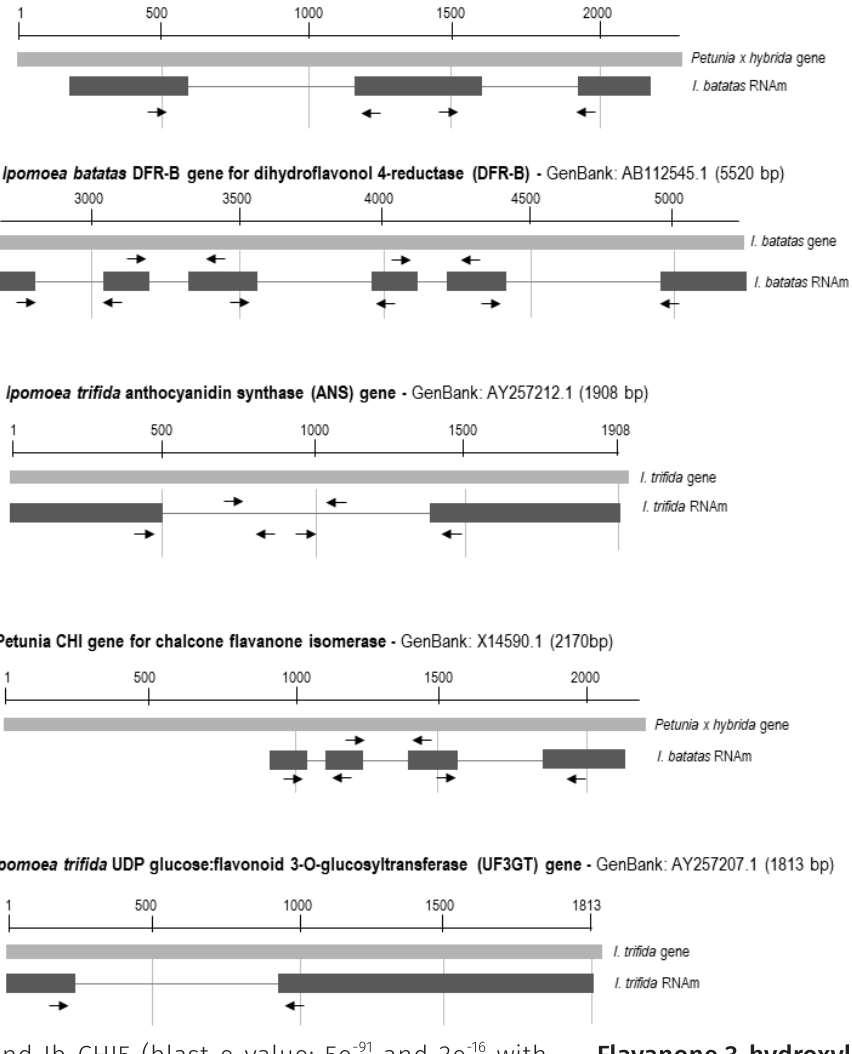
Figure 1. Scheme of the five structural anthocyanin biosynthesis genes. The grey line indicates the gene structure, exons as a black box, and intron as a thin line. Black arrows in opposite directions represent a pair of